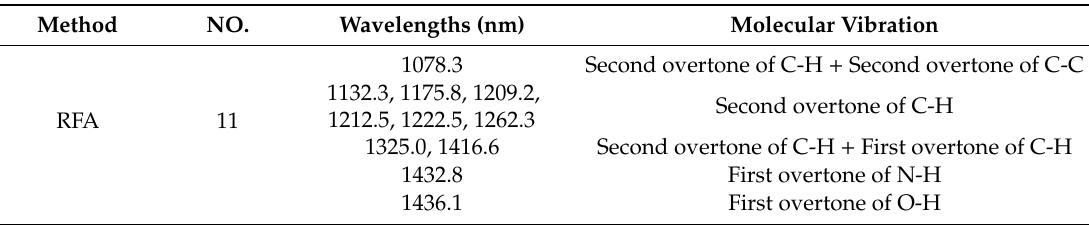
Figure 6. Selection probability of each wavelength by utilizing random frog algorithm (RFA). Table 1. The characteristic wavelengths and the corresponding molecular vibration extracted by random frog algorithm (RFA).